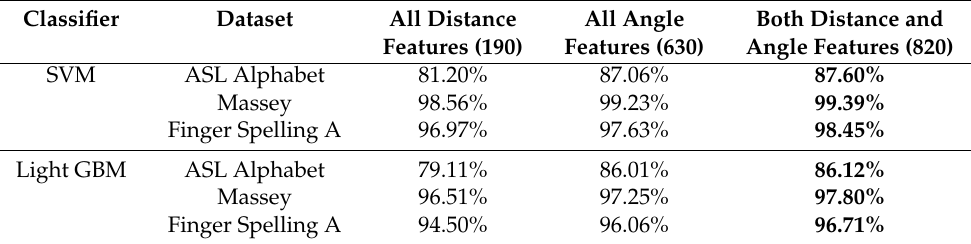
Table 8. Obtained experimental results for considered datasets by using SVM and light GBM.